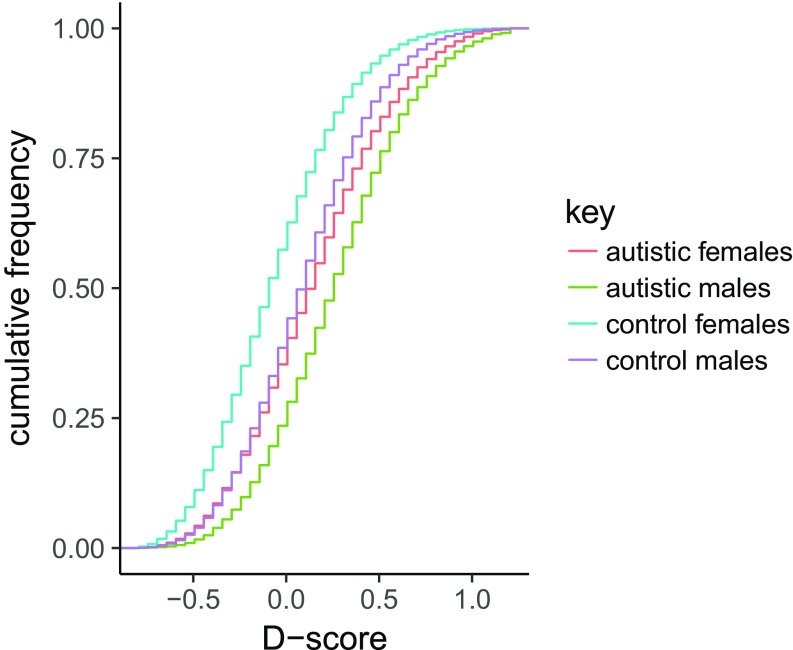
This figure provides the cumulative distribution function based on D-score. The D-score is provided on the x axis and the cumulative frequency on the y axis. Each colored line represents a category based on sex and diagnosis.